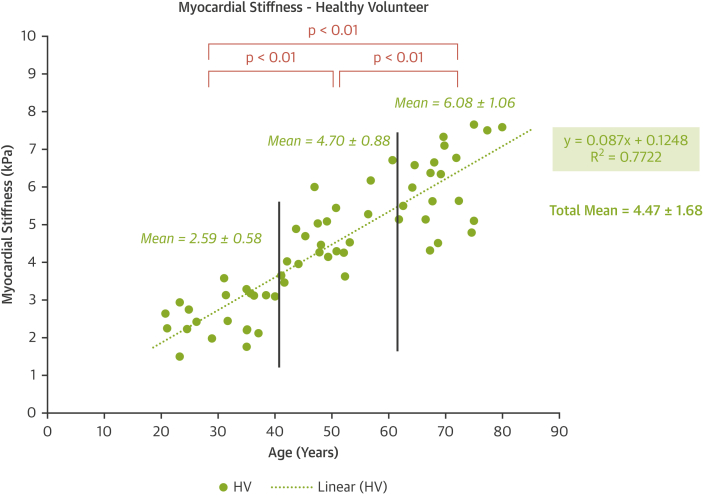
Myocardial Stiffness for Healthy VolunteersMyocardial stiffness measured in HV as a function of age. Abbreviation as in Figure 1.